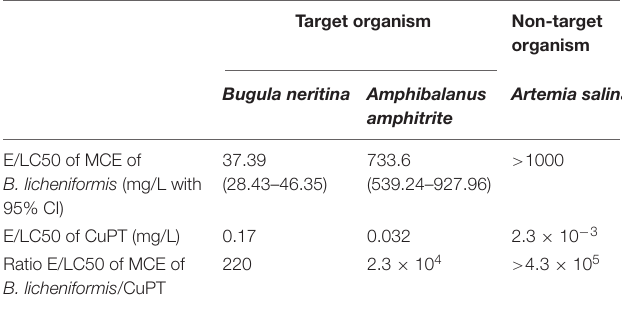
TABLE 1 | Comparison of anti-fouling efficacy (EC50) of B. licheniformis methanol cell extract (MCE) and CuPT against larvae of the bryozoan Bugula neritina and the barnacle Amphibalanus amphitrite and toxicity (LC50) to the brine shrimp Artemia salina .